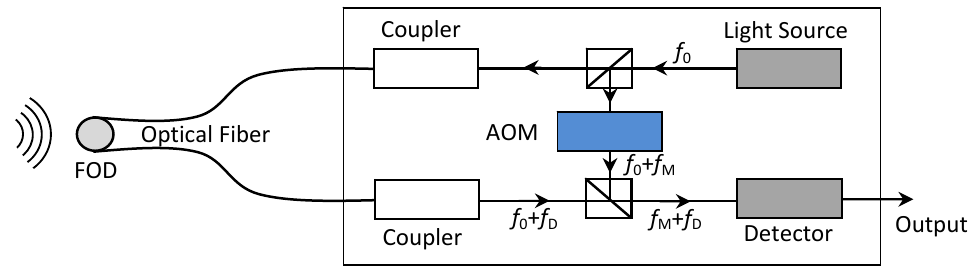
Figure 4. Setup of the laser Doppler velocimeter for the FOD